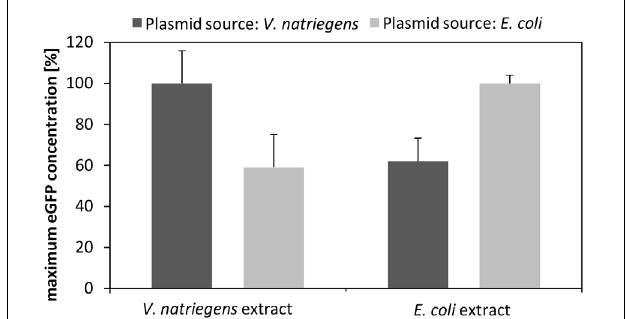
FIGURE 4 | CFPS performed with V. natriegens cell-free extract and identical plasmids prepared from V. natriegens or E. coli . The same experiment was also performed with E. coli extract and plasmids prepared either from V. natriegens or from E. coli . The maximum eGFP concentration obtained after 3 h of an in vitro translation reaction is shown. Plasmid concentrations were kept constant for all experiments.